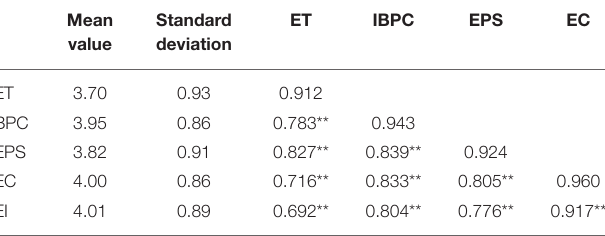
TABLE 3 | Correlation coefficient matrix between the square root of the AVE-value and